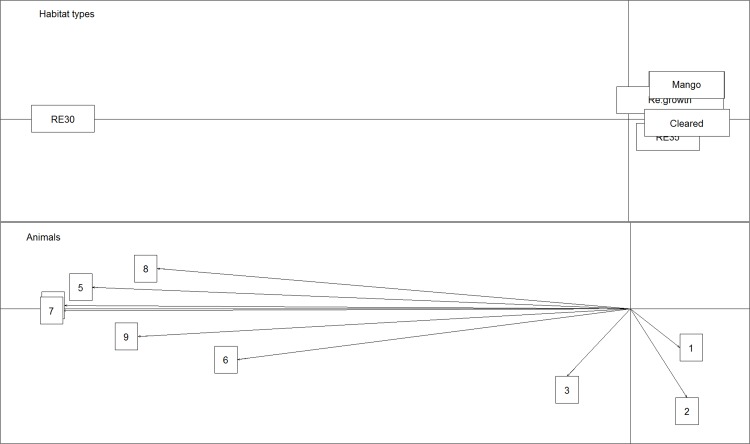
Results of the eigenanalysis of selection ratios to evaluate habitat selection for BTF in Site 2, South Townsville.The top figure shows the habitat types. The bottom figure shows habitat preference of each individual monitored.